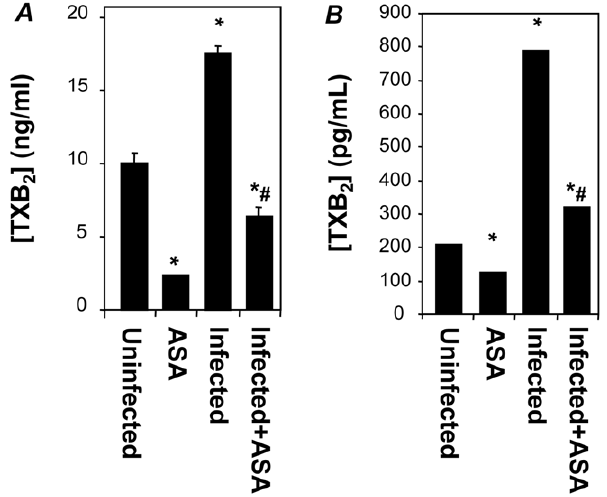
Figure 4. ASA inhibits both host- and T.cruzi -derived prosta- glandin production. Plasma TXA 2 levels, measured as the stable hydrolytic product TXB 2 by ELISA, in uninfected or infected CD1 ( A ) or TXA 2 synthase null ( B ) mice. ASA treatment (20 mg/ml) was initiated on 5 dpi. Circulating levels were assessed at 30 and 20 dpi, respectively. Data (mean 6 SD) are derived from at least 5 mice per group. * and # indicate significance ( P # 0.05) from uninfected mice and infected mice, respectively.